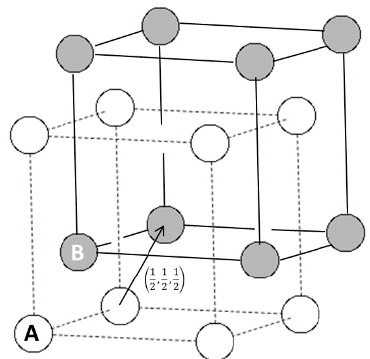
Figure 1. The structure of the ordered B 2 phase. Open (white) and filled (gray) spheres show the A and B lattice sites. Two sub-lattices are displaced by the bcc translation vector.